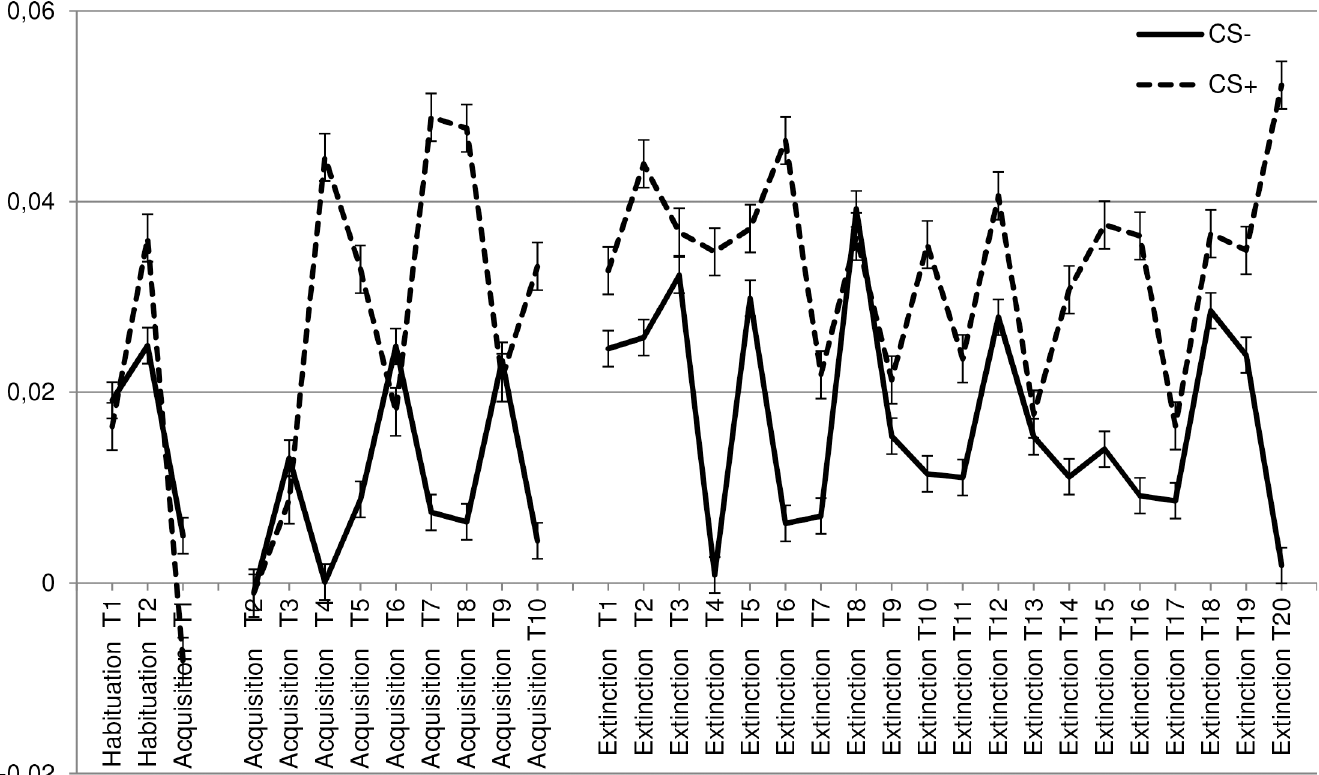
Fig 4. Corrugator conditioned response. Mean response in the different phases (habituation, acquisition, extinction) of the facial corrugator towards the CS+ and CS −